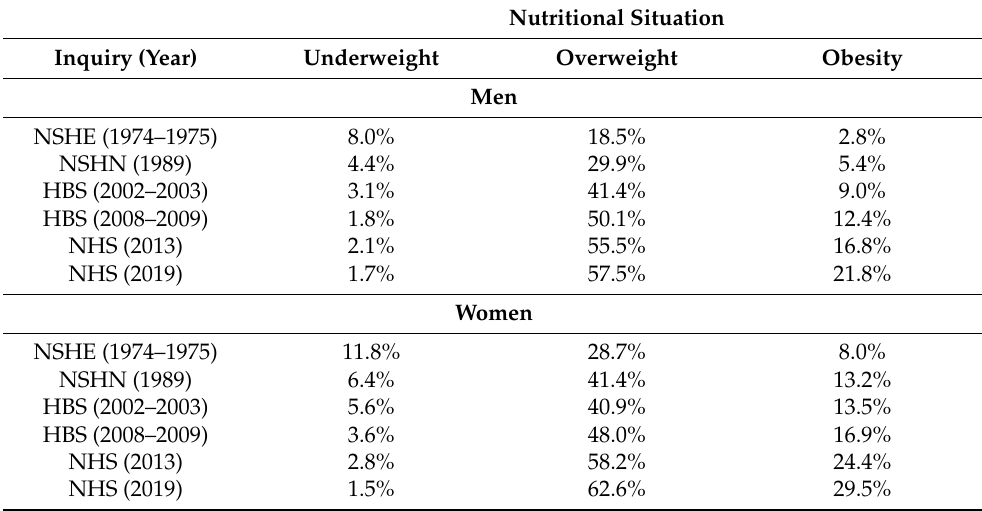
Table 1. Evolutionary trends of the nutritional situation of men and women in Brazil, according to data obtained in national